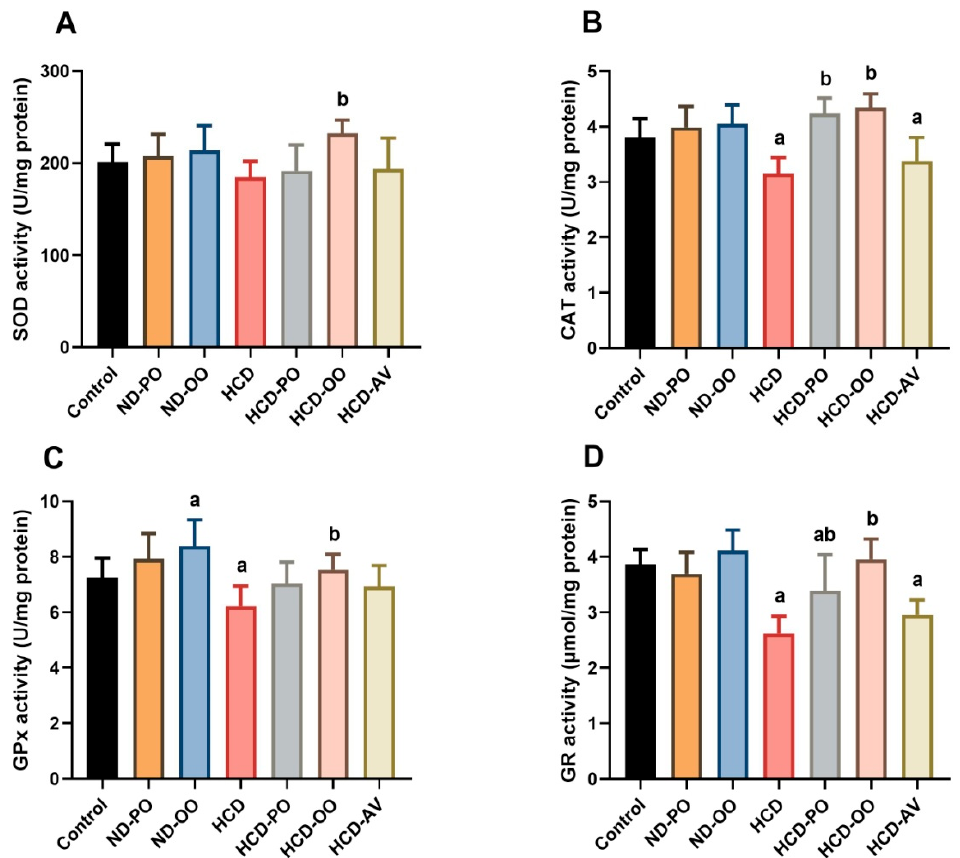
Figure 6. Hepatic levels of oxidative stress markers (( A ) superoxide dismutase, ( B ) catalase, ( C ) glutathione peroxidase, and ( D ) glutathione reductase) following treatment with palm oil (PO), olive oil (OO), or atorvastatin (AV) in high-cholesterol diet-induced hypercholesterolemia in rats.Data are expressed as the mean ± SD ( n = 7). Letters a and b indicate statistically significant differences between control rats and hypercholesterolemia rats, respectively, at p < 0.05.